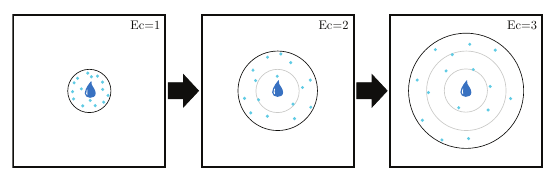
Figure 2. Visual representation of the explosion